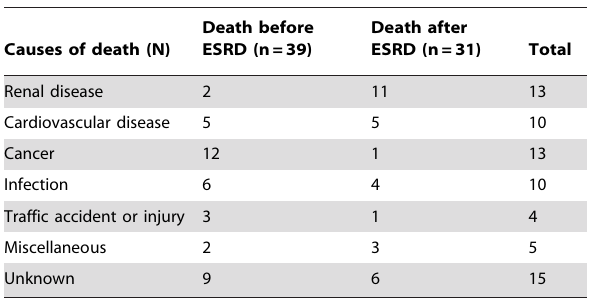
Table 4. Causes of death.